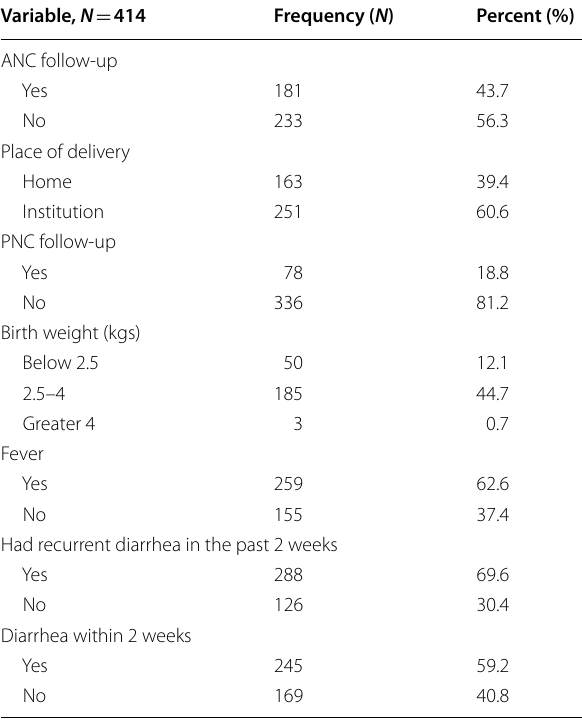
Table 2 Environmental and health care characteristics of children among 6–59 months in Angolalla Tera district, North Shoa, Amhara, Ethiopia, 2021 ( N 414) =